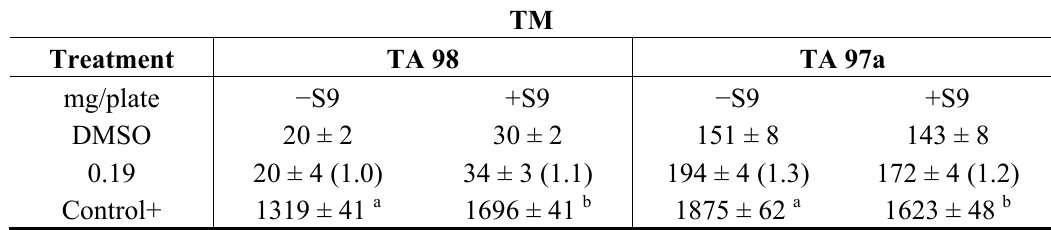
Table 1. Assessment of the mutagenicity of 7,8,3'-trihydroxy-4'-methoxyisoflavone (TM) against S. typhimurium . The table shows the revertants per plate, the standard deviation and the mutagenicity index (in brackets) for strains TA98 and TA97a after treatment with TM.